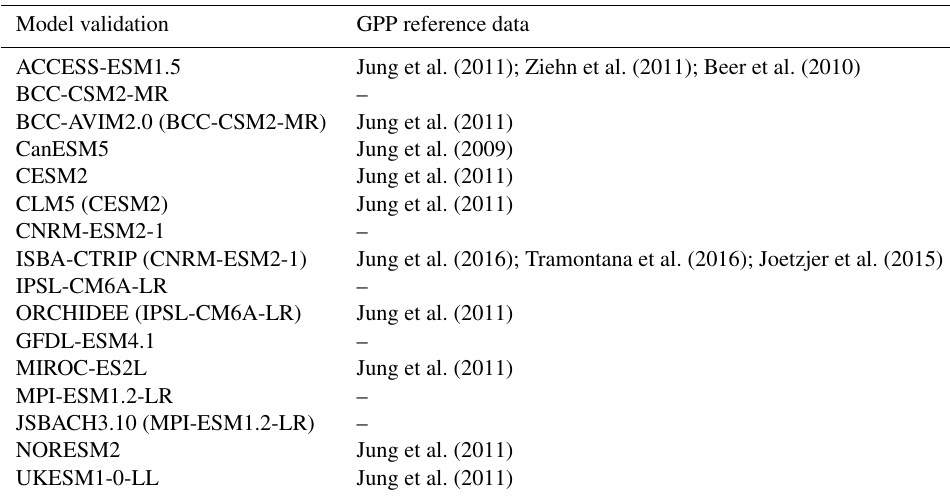
Table 3. The source for gross primary production (GPP) data referenced by each modelling group for ESM or LSM simulations. Adjacent contributions from the same modelling group are banded in a common fashion for readability. LSM-focused validations by each modelling group are presented with the associated ESM in brackets.